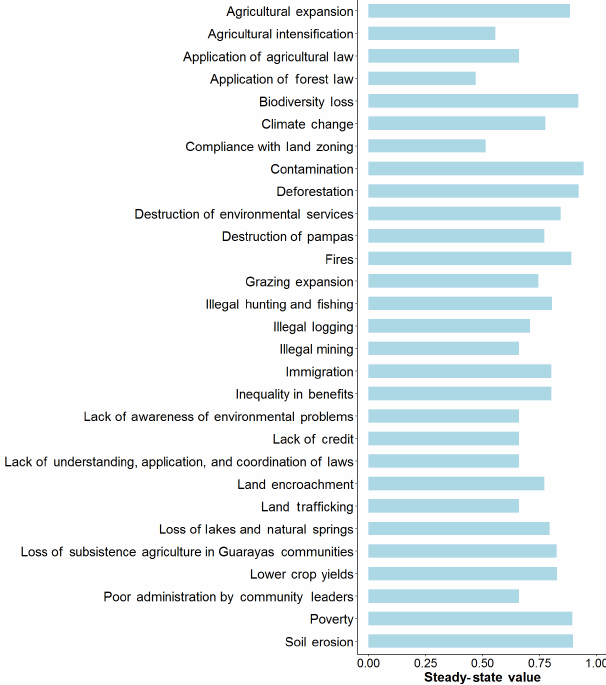
Figure 6. Component values for the Guarayos case study FCM un- der steady-state “baseline” conditions. Values close to 0 represent a strong decrease in the component, whilst values closer to 1 repre- sent a strong increase.